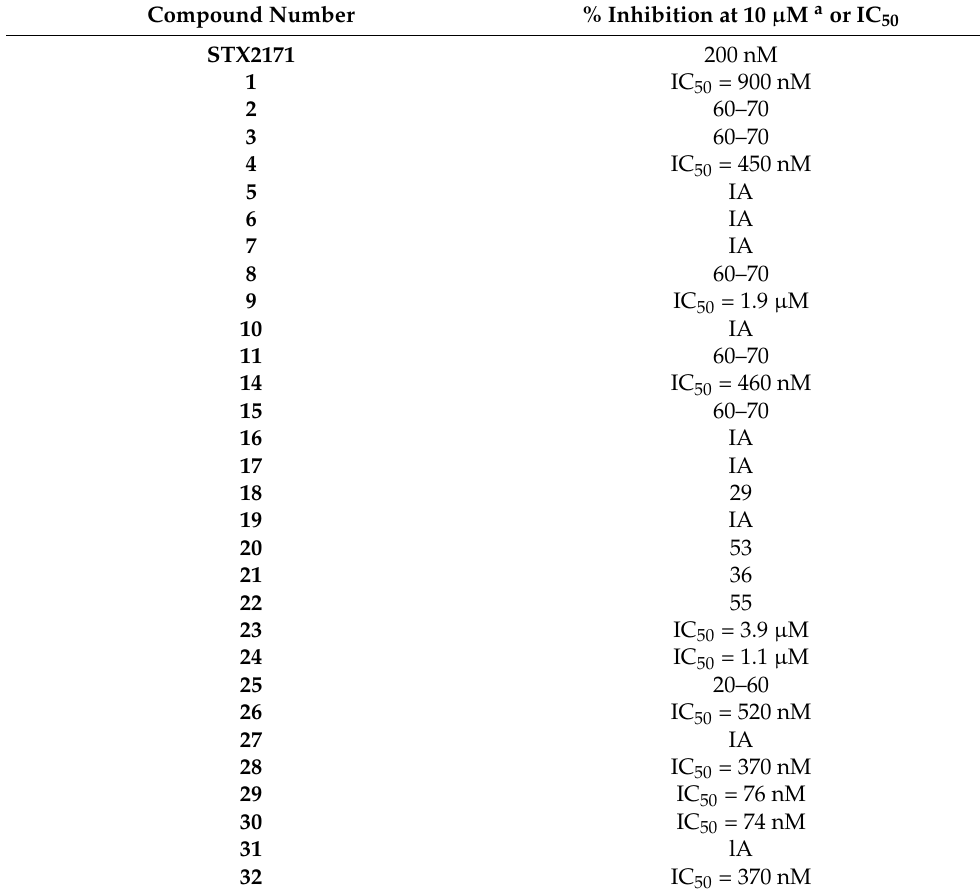
Table 9. a Results obtained from the TLC assay. Mean of at least two measurements with typically an SD of ± 5%. IA